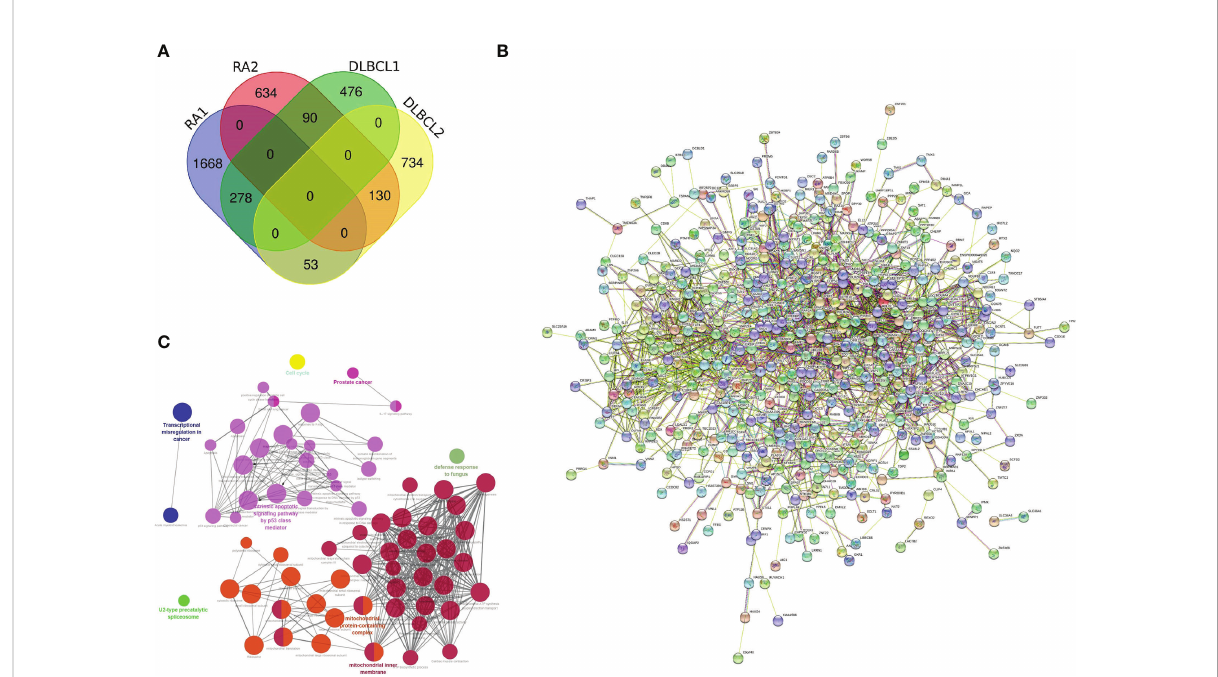
FIGURE 2 Characterization of the shared genes in RA and DLBCL. (A) Venn diagram of the shared genes between the two RA modules and two DLBCL modules; (B) PPI network of 551 shared genes; (C) The network of GO terms in ClueGO. RA, rheumatoid arthritis; DLBCL, diffuse large B-cell lymphoma; PPI, protein-protein interaction; GO, Gene Ontology.